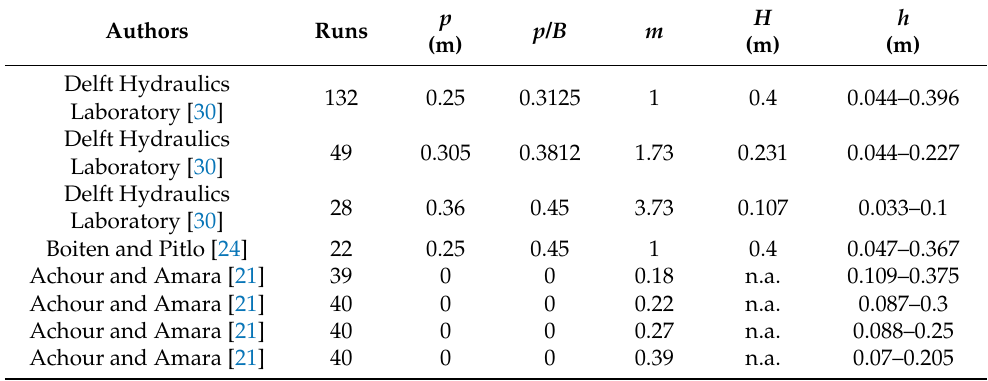
Table 1. Characteristic data of the examined available